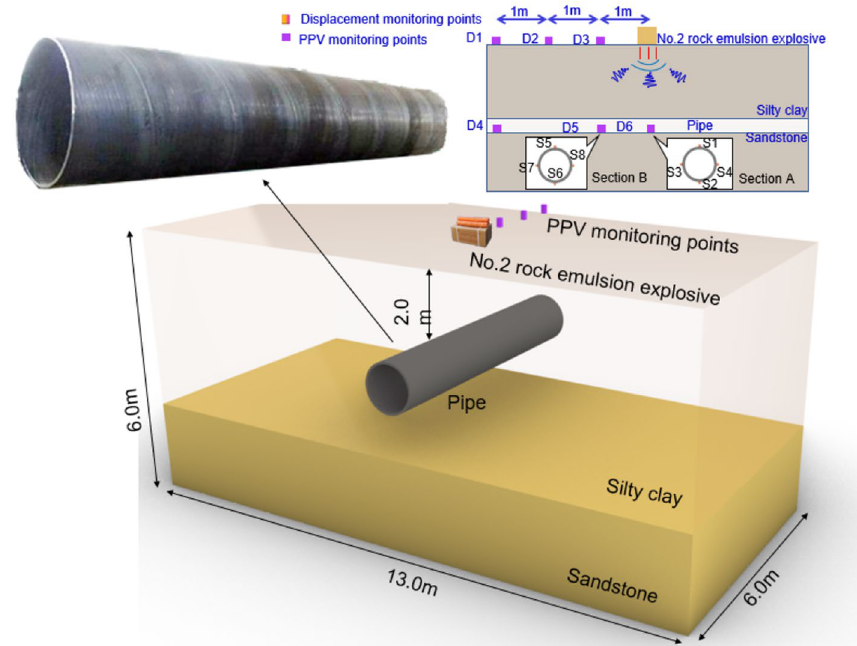
Figure 4. Schematic diagram of the full-scale field tests.